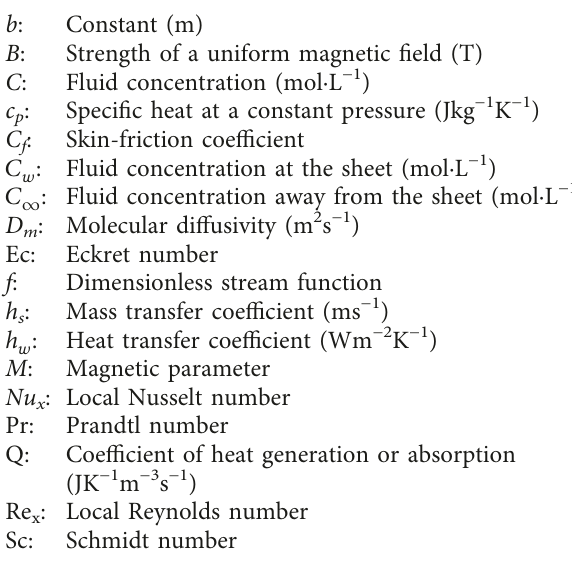
�������� 􏽰 ��� 􏽰 ( 2/ m + 1 ) C Re x , − θ ′ ( 0 ) and − ϕ ′ ( 0 ) for various values of M, β , Λ , ε , Ec , δ , c , and λ with m � 0 . 5 , Pr � 1 . 5, f